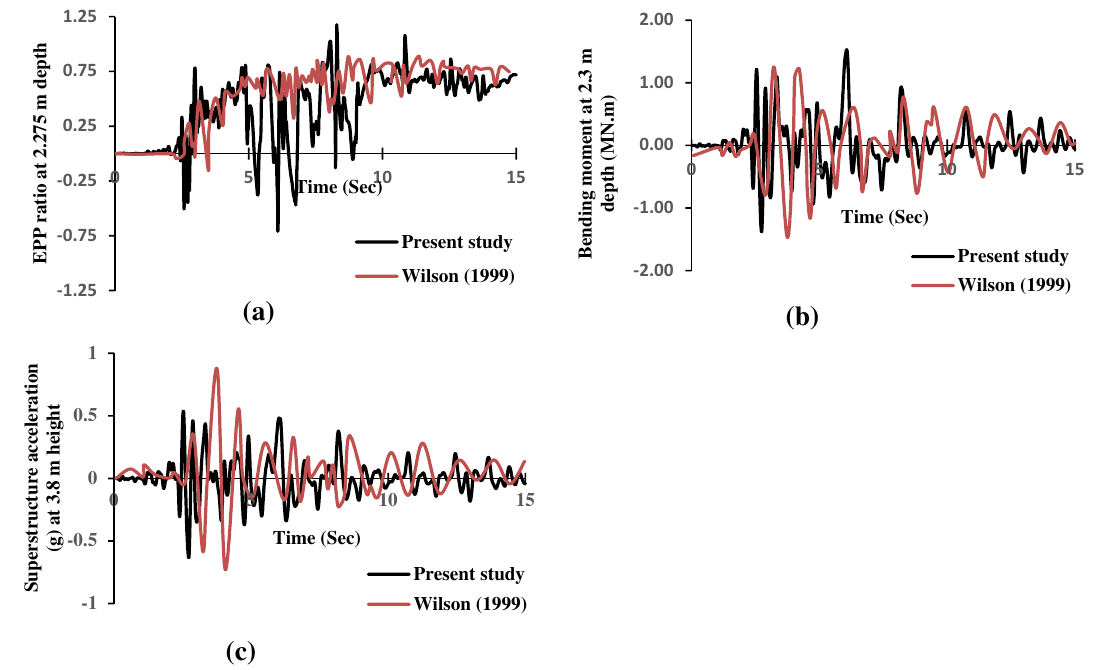
Fig. 6 Comparison of present study with dynamic centrifuge tests conducted by Wilson [2] a EPP time-history b bending moment time- history and c superstructure acceleration time-history